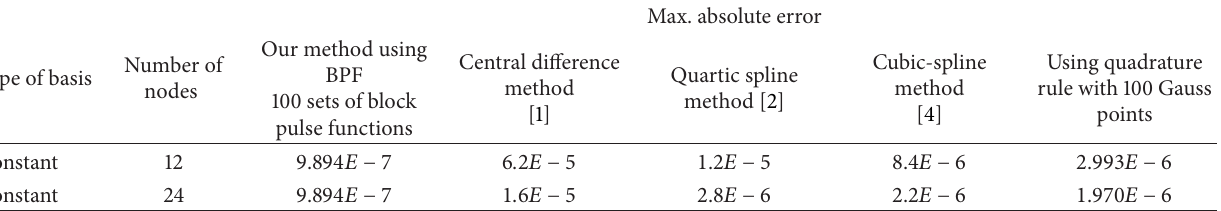
Table 2: Observed maximum errors for Problem 2, using BPF (25).